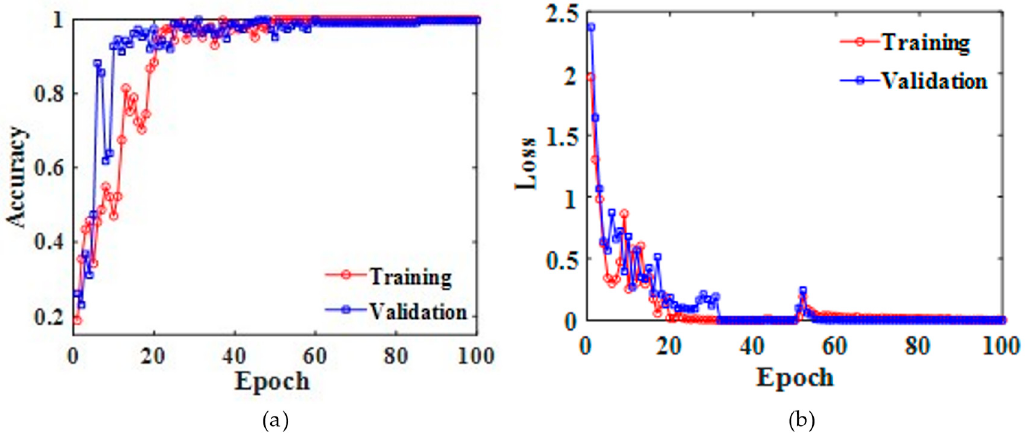
Figure 8. Training process of SRMANet. ( a ) Cross-entropy Loss, ( b ) Accuracy.